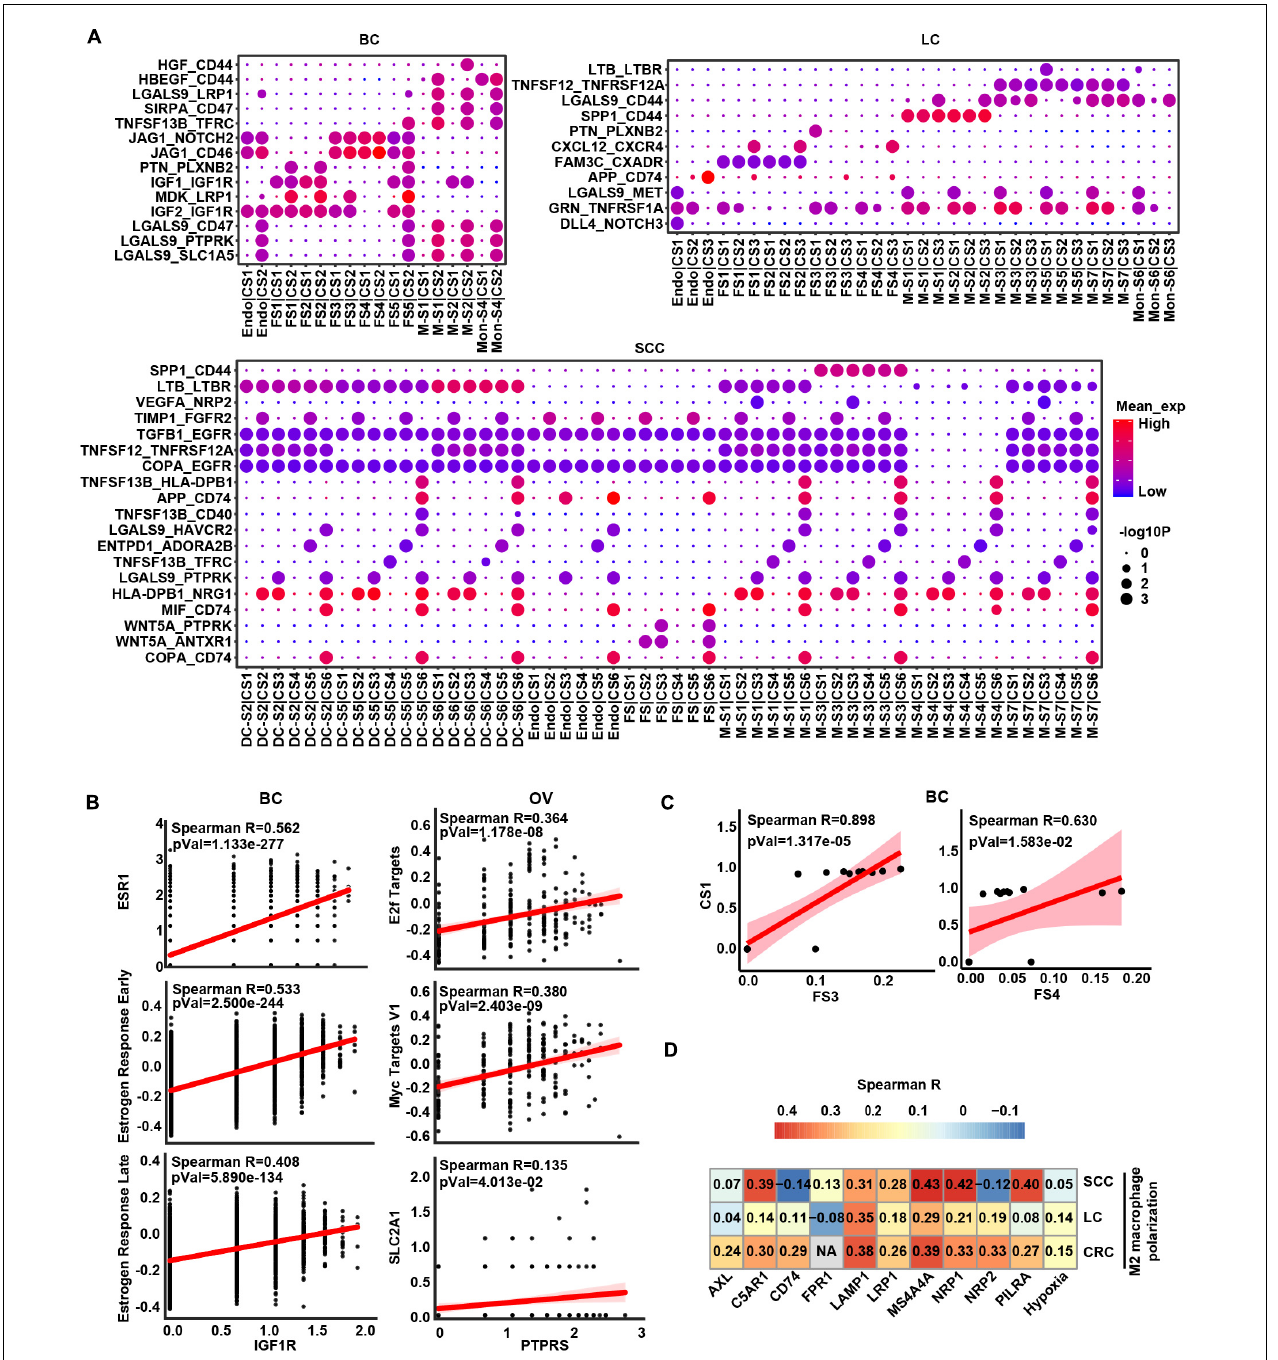
FIGURE 4 | The intercellular interactions between non-malignant cells and cancer cells. (A) Significant ligand–receptor genes accounting for specific intercellular interactions in BC, LC, and SCC. P -values are indicated by circle size. The means of the average expression level of interacting molecule (ligand or receptor genes) 1 in cluster 1 and interacting molecule 2 in cluster 2 are indicated by color. Subclusters 0, 1, 2, 3, and 4 of stroma cells were labeled FS1, FS2, FS3, FS4, and FS5 in each cancer type. Subclusters 0, 1, 2, 3, and 4 of cancer cells were labeled CS1, CS2, CS3, CS4, and CS5 in each cancer type. Subclusters 0, 1, 2, 3, and 4 of macrophages/monocytes/dendritic cells were labeled M-S1/Mon-S1/DC-S1, M-S2/Mon-S2/DC-S2, M-S3/Mon-S3/DC-S3, M-S4/Mon-S4/DC-S4, and M-S5/Mon-S5/DC-S5 in each cancer type. Endo is endothelial cells. (B) Correlation scatter plot between main receptors expressed on cancer cells and specific pathways as well as genes in BC and OV. (C) Correlation between proportional changes in specific stromal cell cluster and cancer cell cluster in BC. (D) Heatmap depicts the correlations between M2 macrophage polarization and hypoxia as well as main receptors expressed on macrophage.